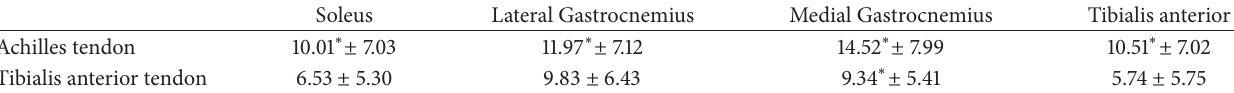
Table 1: The increase rate of muscle force by vibration stimulation applied on the Achilles tendon and tibialis anterior tendon [%].